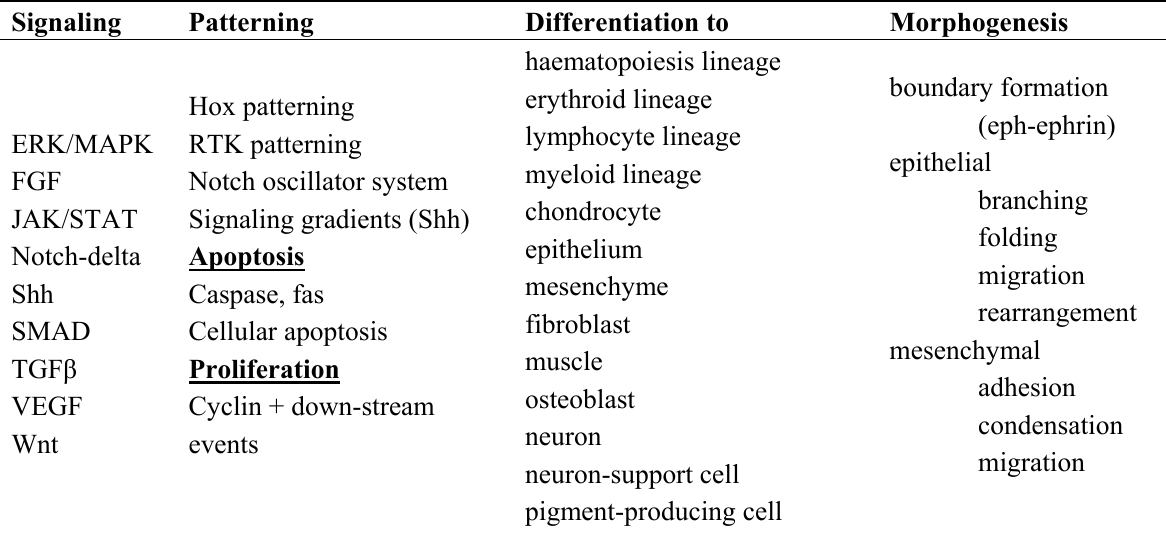
Table 2. Some major networks whose outputs are the processes that drive